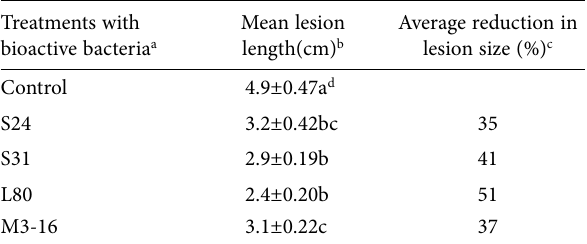
Table 3. In planta antagonistic activity of four bioactive bacteria toward Phytophthora